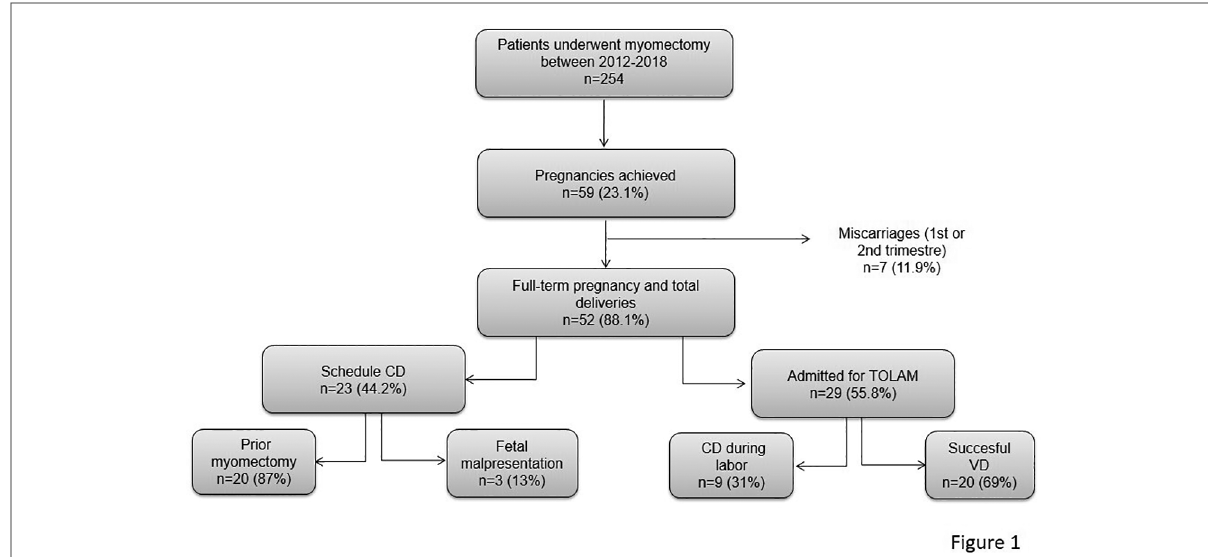
FIGURE 1 Flow diagram of study population: pregnancy and delivery outcomes in patients who underwent laparoscopic and abdominal myomectomy. CD, cesarean delivery; TOLAM, trial of labor after myomectomy; VD, vaginal